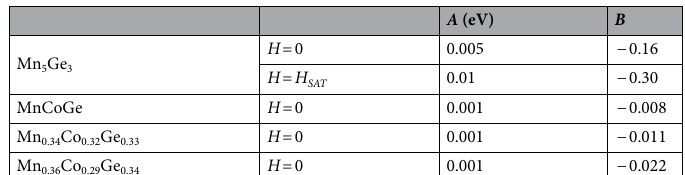
Table 1. Parameters A and B in Eq. (4) determined experimentally from S measurements presented in Fig. 3b for Mn 5 Ge 3 films and Fig. 3e for Mn x Co y Ge 1− x − y films.